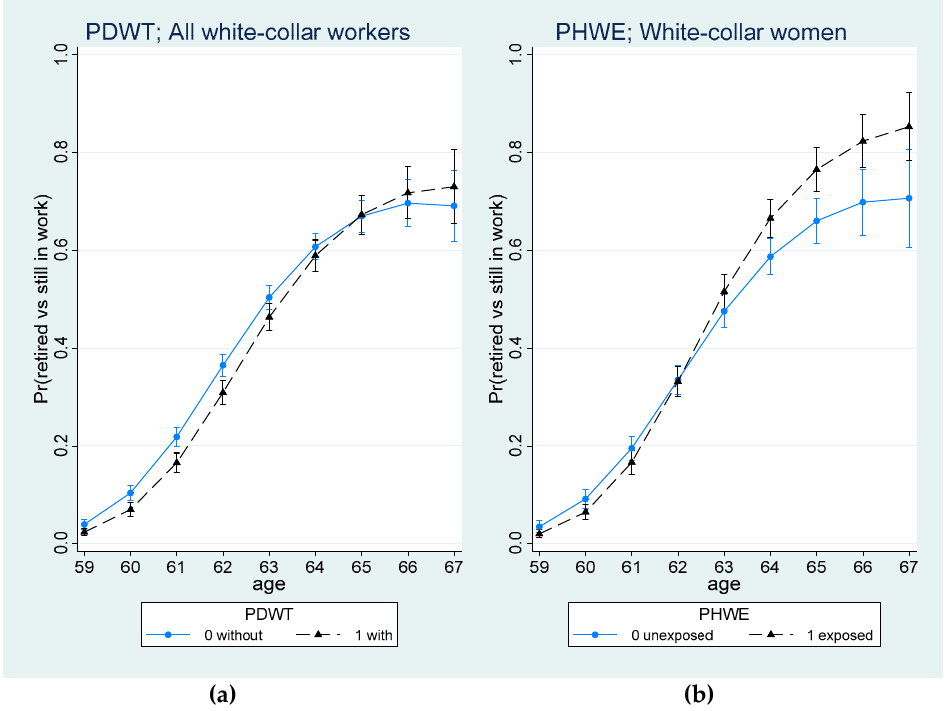
Figure 2. Predictive marginal probability (and 95% CI) of retiring (vs. still in work) at 2-year follow-